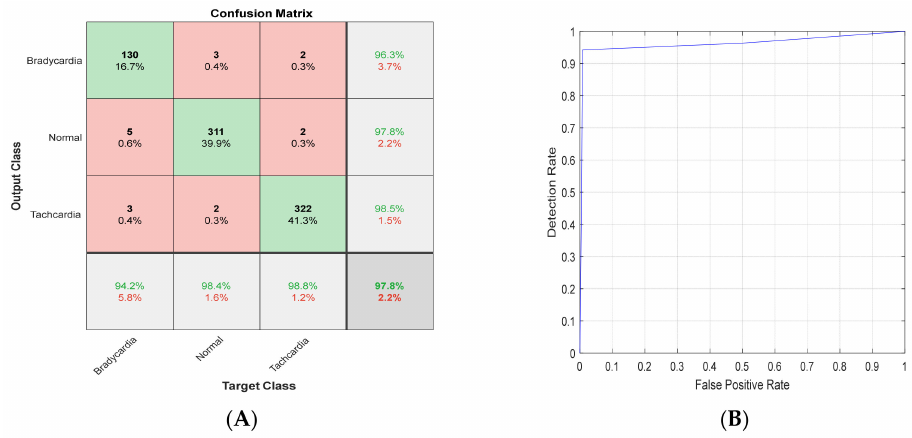
Figure 17. ( A ) Confusion matrix and ( B ) ROC for ResNet101 with Scalogram T-waves.